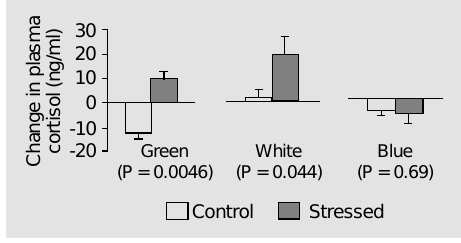
Table 1. Mean (± SD) plasma cortisol levels (ng/ml, N = 8) of adult Nile tilapia, Oreochromis niloticus , before (basal) and after a color regime. Group Light color Green